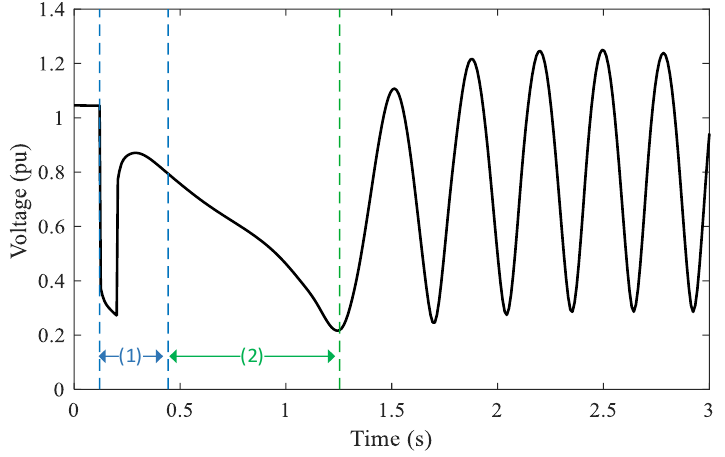
Figure 14. RCNN time delay in real-time for an unstable study case. (1) Total delay time assessment. (2) Remaining time between assessment result and unstable condition.